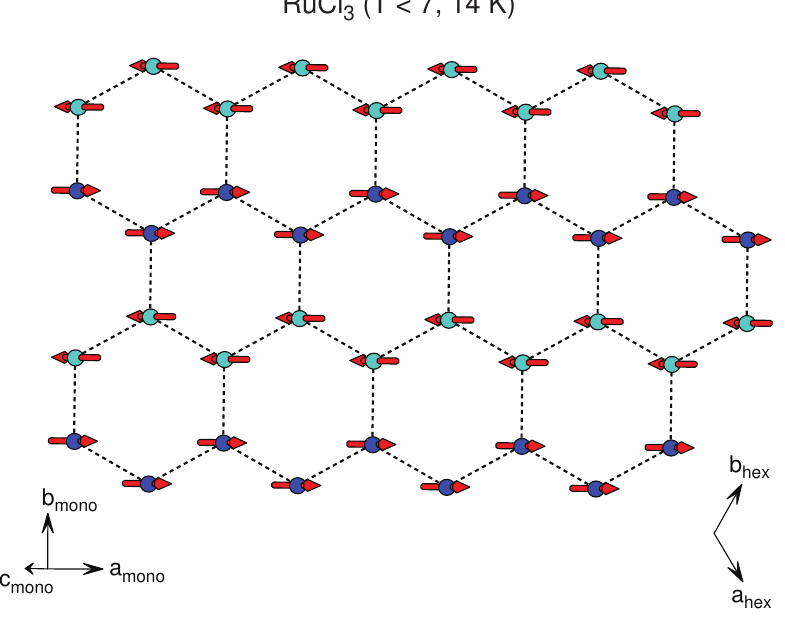
Figure 10. The zig-zag in plane magnetic structure of RuCl 3 . Coordinate systems corresponding to the underlying monoclinic and hexagonal crystal lattices are shown. The moments lie in the monoclinic ac plane, but the direction in this plane is not known